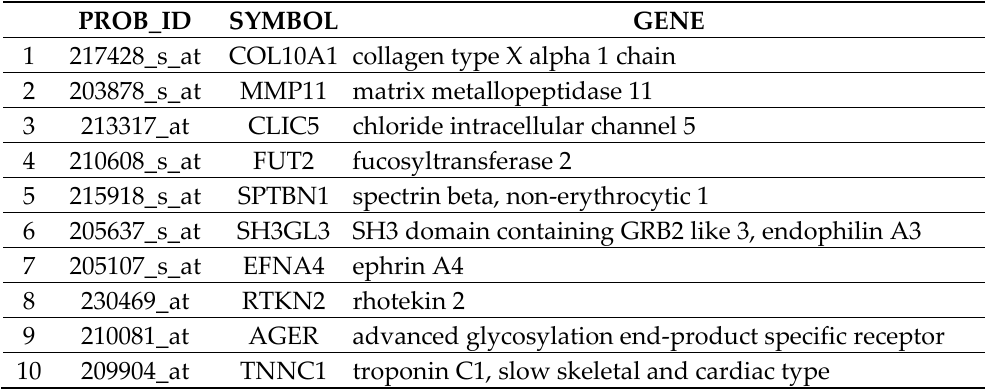
Table 1. Table of top 10 candidate differentially expressed genes identified with random forest model.